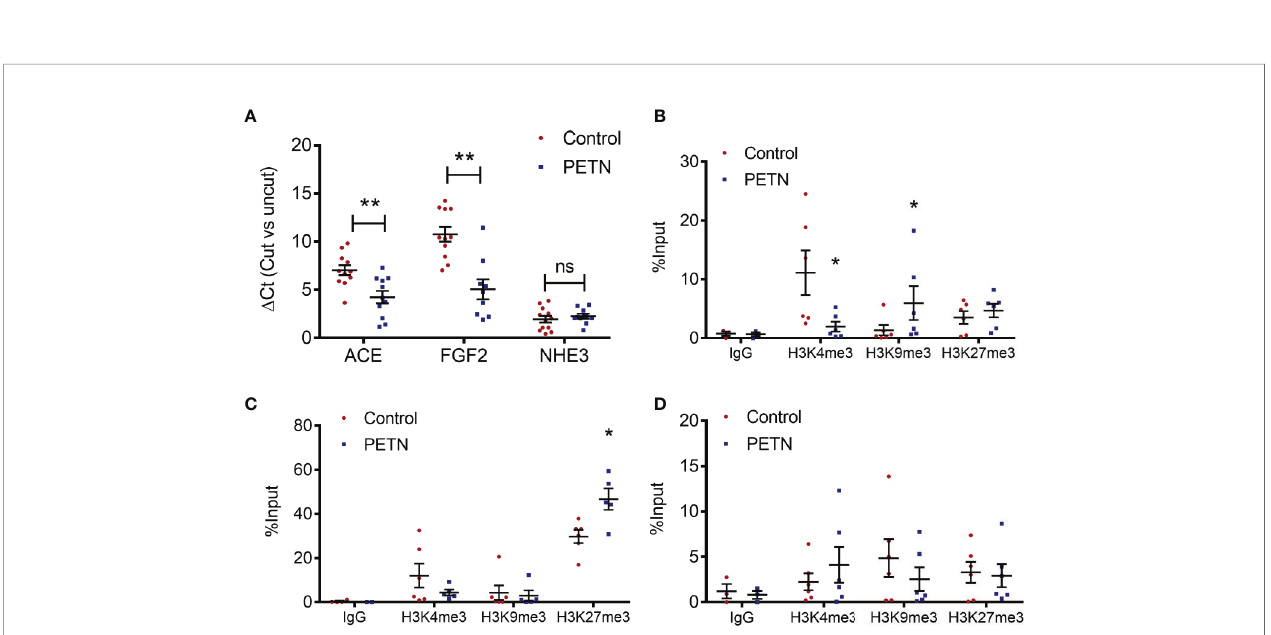
FIGURE 3 | Maternal pentaerythritol tetranitrate (PETN) treatment leads to epigenetic changes in the kidney of female offspring. Parental spontaneously hypertensive rats (SHR) were treated with or without PETN (50 mg/kg/day) during pregnancy and lactation periods. (A) The chromatin accessibility at the proximal promotor regions around the transcription start site of ACE, FGF2, and NHE3 was studied by MNase digestion. Histone 3 lysine 4 trimethylation (H3K4me3), histone 3 lysine 9 trimethylation (H3K9me3), and histone 3 lysine 27 trimethylation (H3K27me3) at the proximal promotor regions around the transcription start site of angiotensin- converting enzyme (ACE) (B) , fi broblast growth factor (FGF2) (C) and sodium-hydrogen antiporter 3 (NHE3) (D) were studied with chromatin immunoprecipitation (ChIP) followed by quantitative PCR using kidney of 16-week-old offspring. Nonspeci fi c IgG was used as negative control of the ChIP experiment. Column represents mean ± SEM, n= 6. Student ’ s t test was used for comparison of PETN group with control group. Student ’ s t test was used for comparison of PETN group with control group. * P < 0.05; ** P < 0.01 vs. control